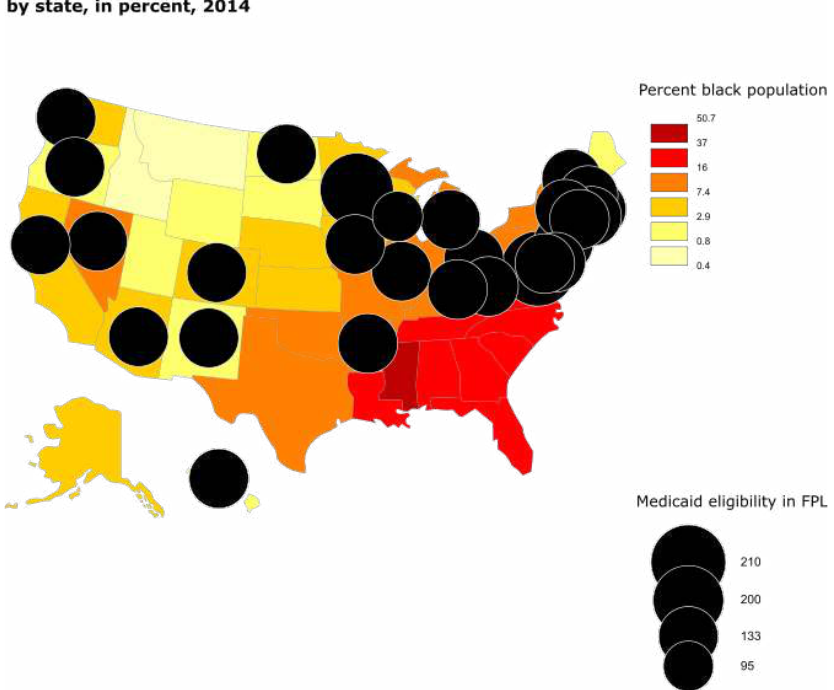
Data: Medicaid.gov,